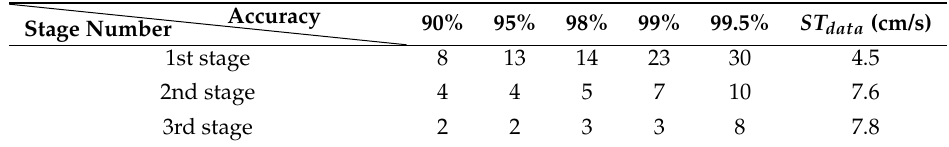
Figure 3. The relationship between Womersley’s analytical solution and dynamic mode decomposition (DMD) approximation is shown in a rigid tube. Top left : The pressure gradient waveform driving the flow in the rigid tube is shown. Corresponding Fourier series coefficients and frequencies are reported in the table. Top right : The Womersley solution for velocity profile at t = 0.3 s is outlined, and the corresponding coefficients, frequencies, and analytical forms are reported. Bottom : The DMD algorithm is reported. Moreover, the location of discrete eigenvalues in the unit circle is shown and the reconstructed velocity profile based on each eigenvalue is sketched. The assembled velocity profile based on all of the DMD modes and the corresponding frequencies are demonstrated. Table 1. The minimum number of modes required to reach a specified reconstruction accuracy in velocity data is shown for the coronary artery stenosis model. The spatiotemporal average of data ( ST data ) is shown for each stage.